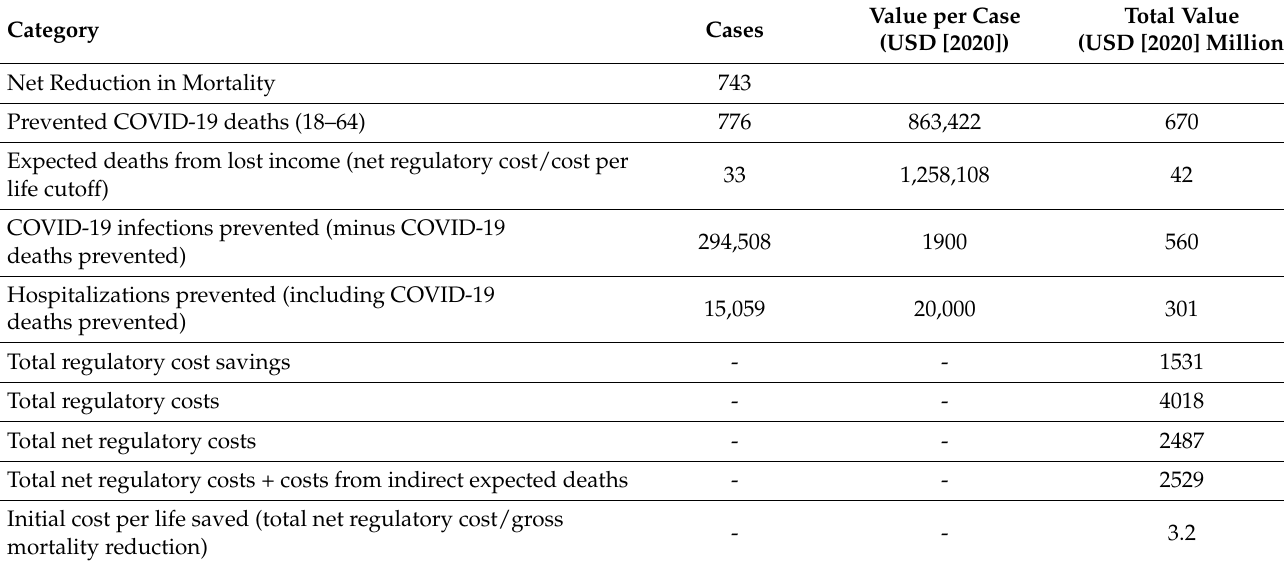
Table 1. Initial Period Costs, Cost Savings, and Total Net Costs of OSHA’s Occupational Exposure to COVID-19 Emergency Temporary